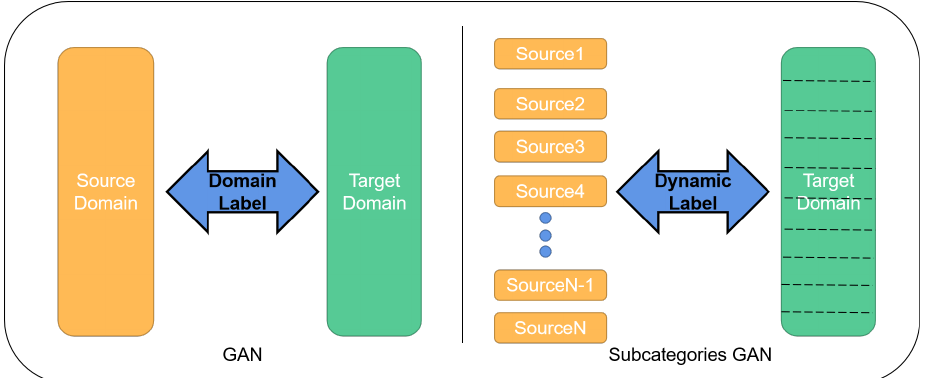
Figure 6. GAN uses the domain label to divide the data into two categories. The multi-label GAN uses the source domain labels to divided the data into N subcategories, while the target domain data uses corresponding dynamic labels to reduce the difference with the source domain